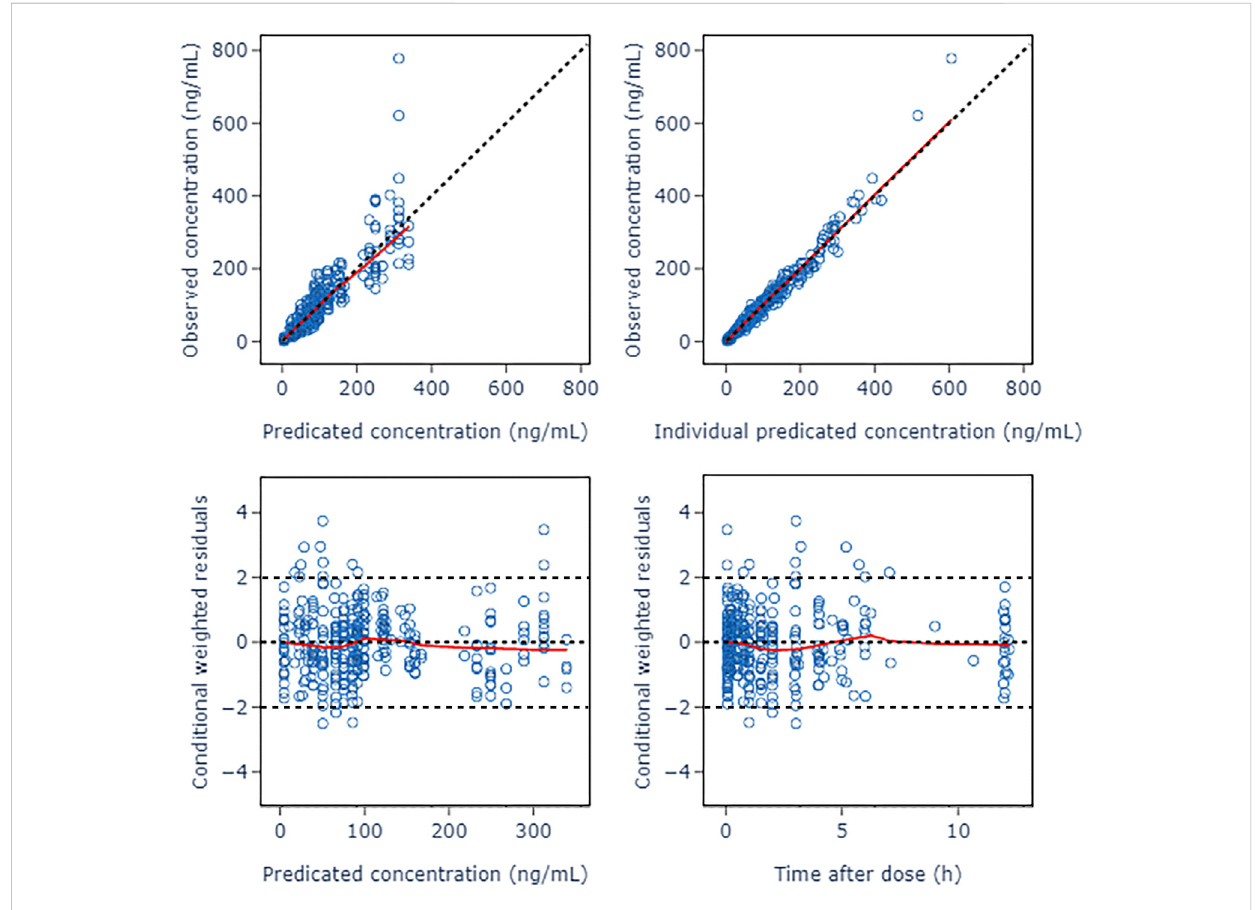
FIGURE 2 Goodness of fi t plots of nalbuphine basic PopPK model. The red lines represent the locally weighted scatterplot with smoothing.